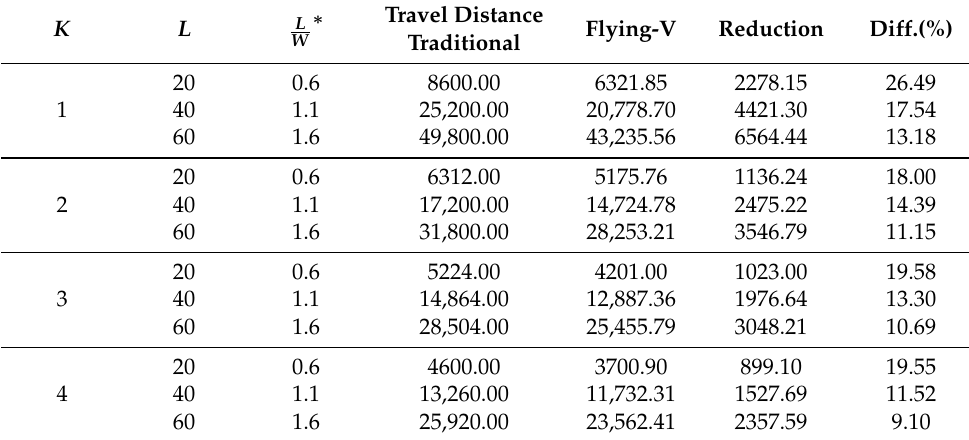
Table 12. Total distance comparison ( N = 20).